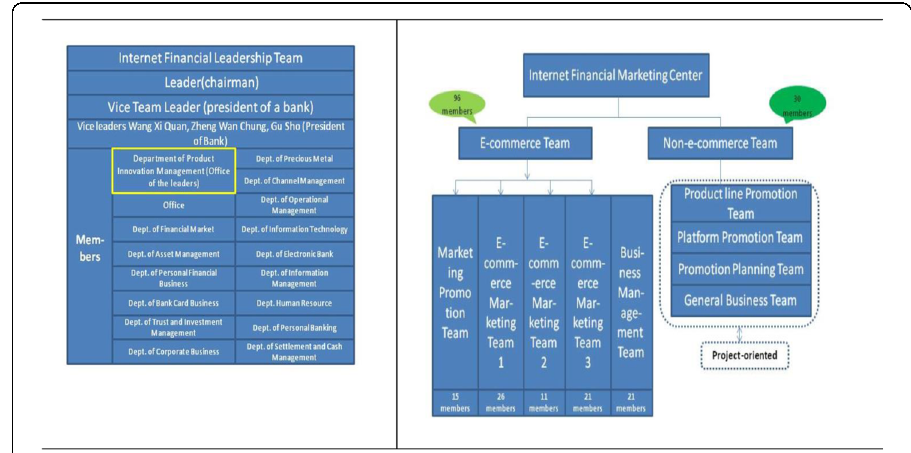
Fig. 2 Organizational structure of Internet finance at